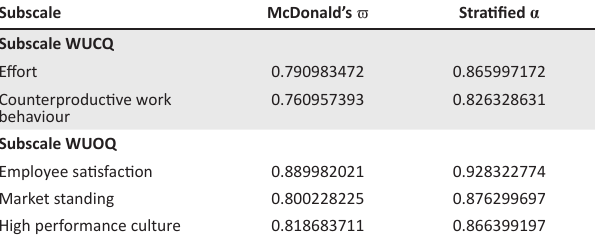
TABLE 4 : The multidimensional McDonald’s ϖ and the stratified α for the Work- Unit Performance Questionnaire subscales for which the unidimensionality assumption had not been